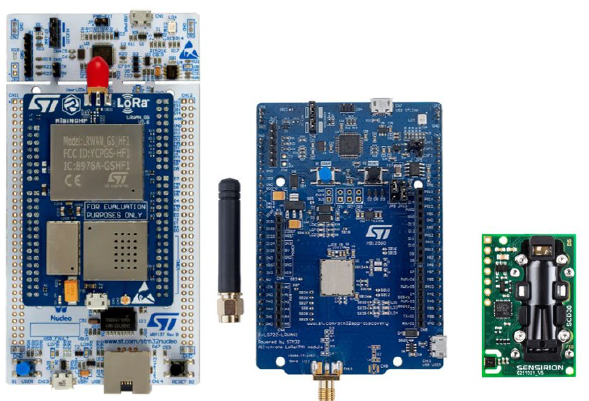
Fig. 5. NUCLEO board, B - L072 - LRWAN1 and SCD30